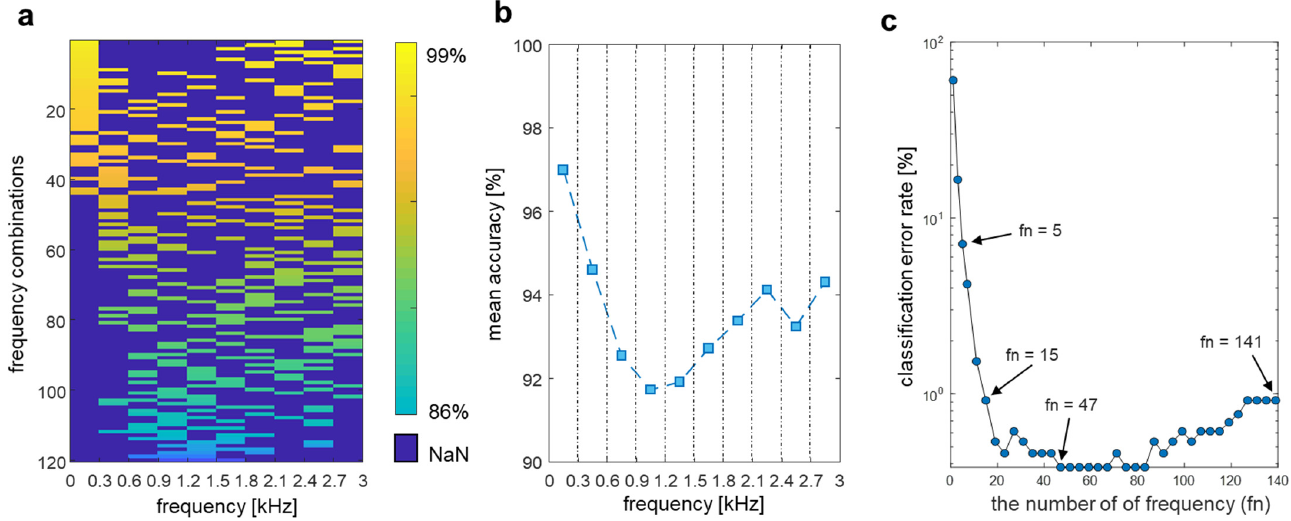
Figure 7. Identity recognition feature optimization using selective frequency scan. ( a ) The accuracy of each selected frequency combination. The more accurate combination is located at higher positions in the image, and lighter yellow indicates higher accuracy. ( b ) Average classification accuracy of each frequency sections in all combinations. ( c ) Classification accuracy with the increasing number of frequencies using the forward-selection method.